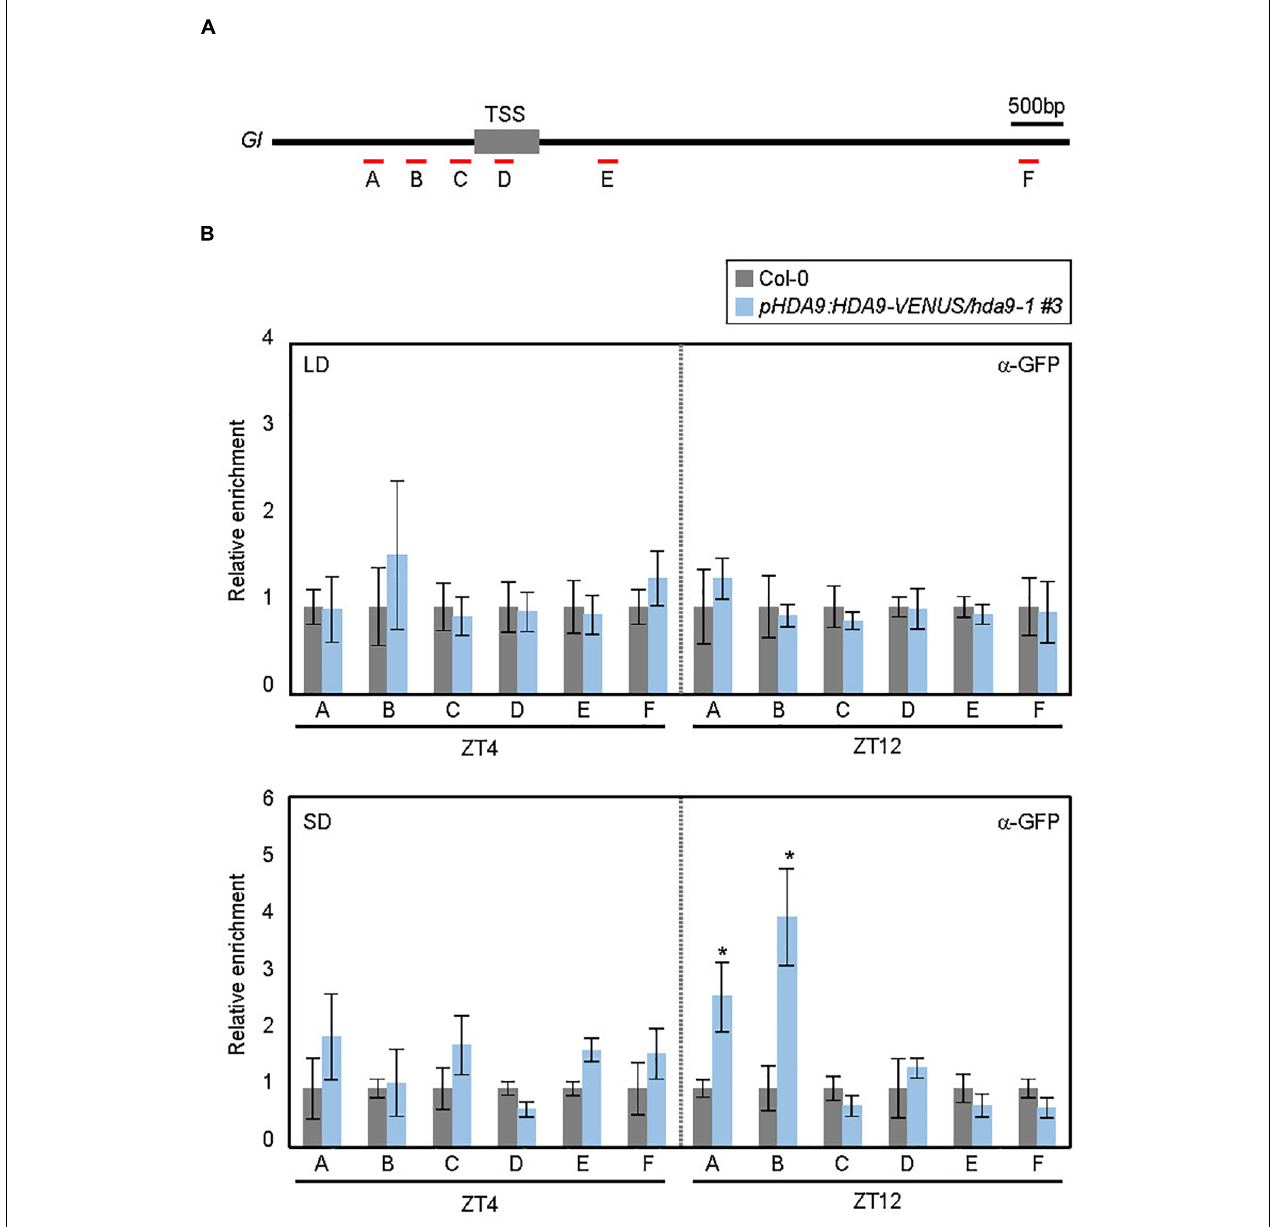
FIGURE 4 | HDA9 binds to the GIGANTEA ( GI ) promoter. (A) Genomic structure of GI . Underbars indicate the regions amplified by PCR following chromatin immunoprecipitation (ChIP). (B) HDA9 binds to the GI locus in short days (SDs). Seven-day-old seedlings grown under long day (LD) and short day (SD) conditions were harvested at ZT4 and ZT12, and subjected to the ChIP assay using anti-GFP antibody. Three biological replicates were averaged. Error bars indicate the SEM. Statistical significance of the differences between Col-0 (wild type) and pHDA9:HDA9-VENUS/hda9-1 transgenic plants were analyzed by Student’s t -test (* P <